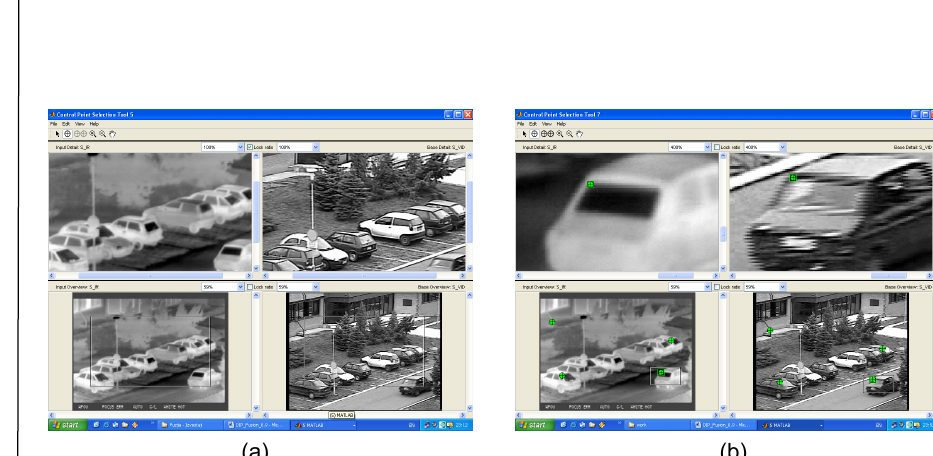
Slika 9 – Radni prozor programskog paketa „Matlab 7.0”: (a) pre izbora kontrolnih ta č